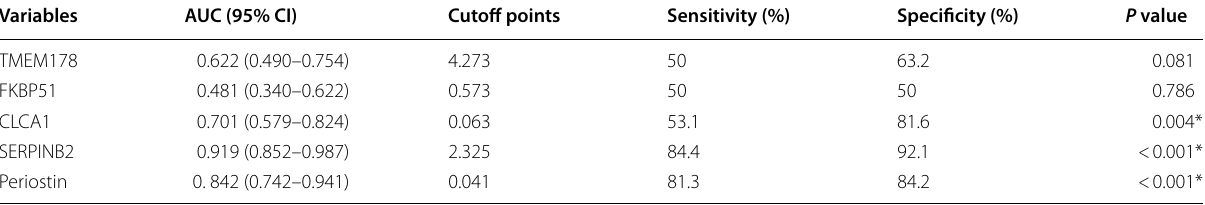
CI: confidence interval, TMEM178: transmembrane protein 178, CLCA1: chloride pathway, calcium activated family member 1, SERPINB2: serpin peptidase inhibitor, clade B, member 2 * P < 0.05 is